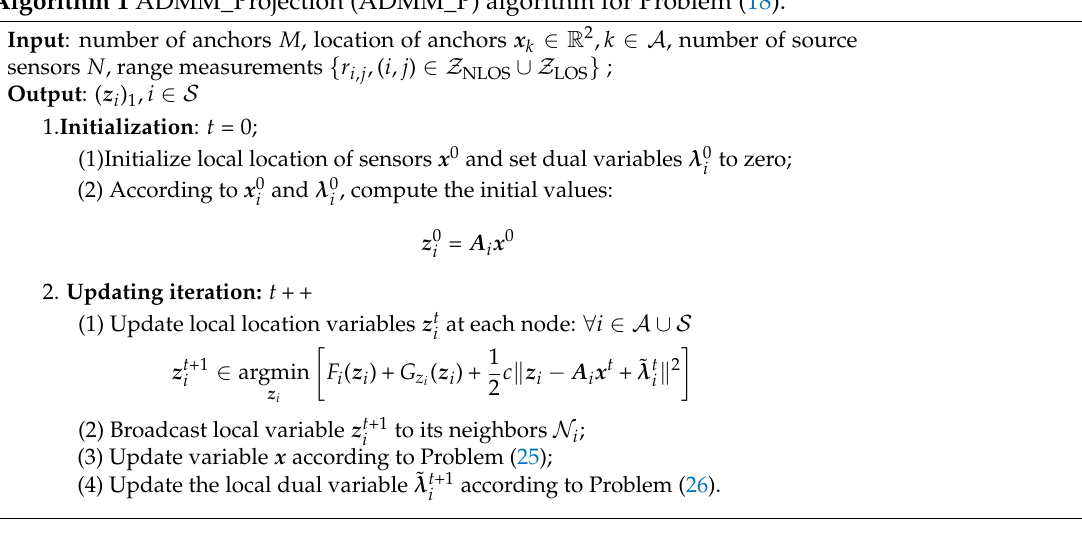
Algorithm 1 ADMM_Projection (ADMM_P) algorithm for Problem (18).